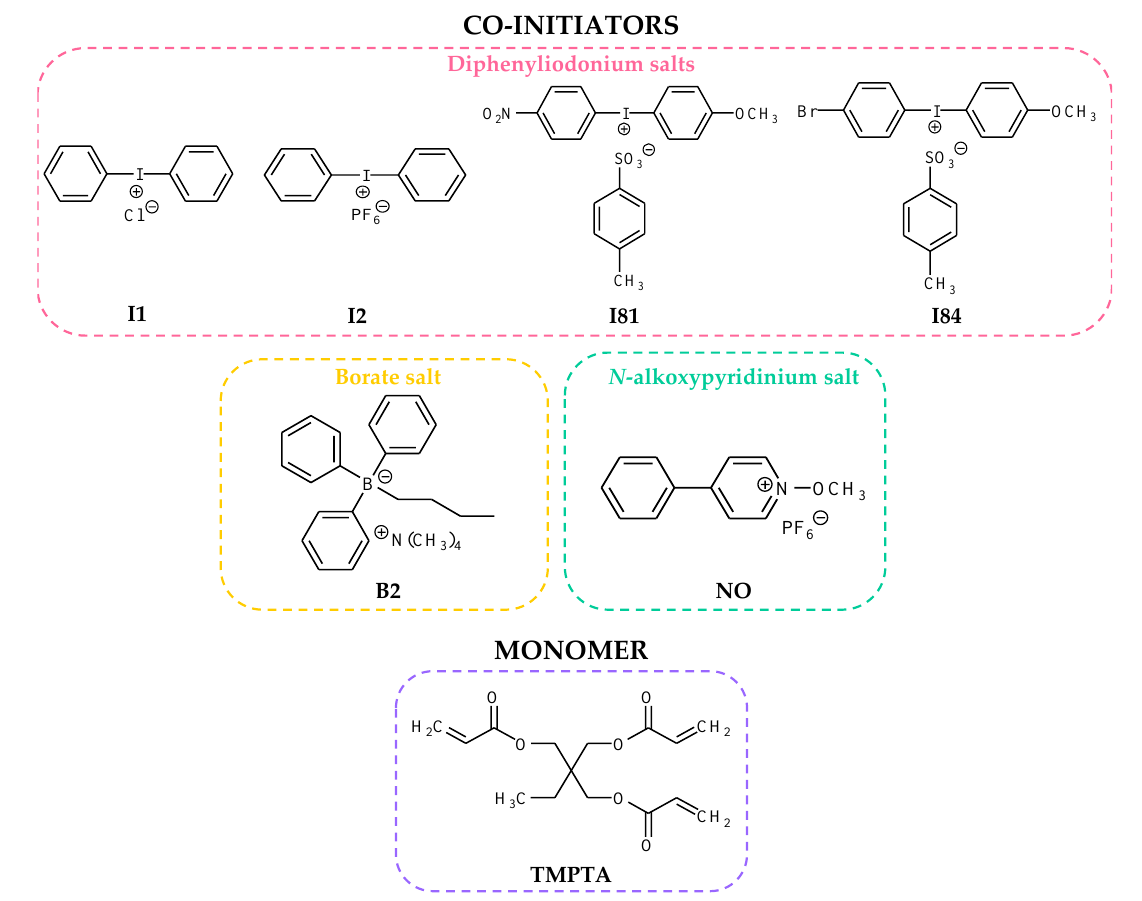
Figure 12. Chemical structures of co-initiators and monomer. The proposed systems were a combination of an appropriate sensitizer, i.e., squaraine dye (SQM1-SQM3), pyrrole derivative (PSQ1/PSQ2/BPSQ1/BPSQ2) or boron dipyrromethene (BODIPYs 1 – 8), with a selected co-initiator, such as diphenyliodonium salts (I1, I2, I81, I84), borate salt (B2) or N -alkoxypyridinium salt (NO). Depending on the chemical structure of the dye used, novel photoinitiators operate upon ultraviolet (UV), visible (Vis) or UV-Vis light, as shown in Figure 13.